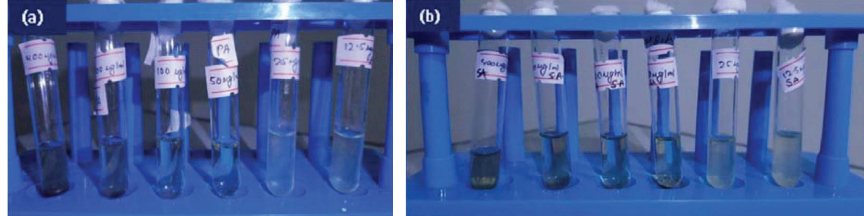
Figure 15: Te broth dilution method for the determination of MIC of AgNPs on (a) P. aeruginosa and (b) S. aureus . Te test tube from right to left contains 12.5 μ g/ml, 25 μ g/ml, 50 μ g/ml, 100 μ g/ml, 200 μ g/ml, and 400 μ g/ml of AgNPs, respectively. Turbidity was seen from 50 μ g/ ml concentration in both bacteria.